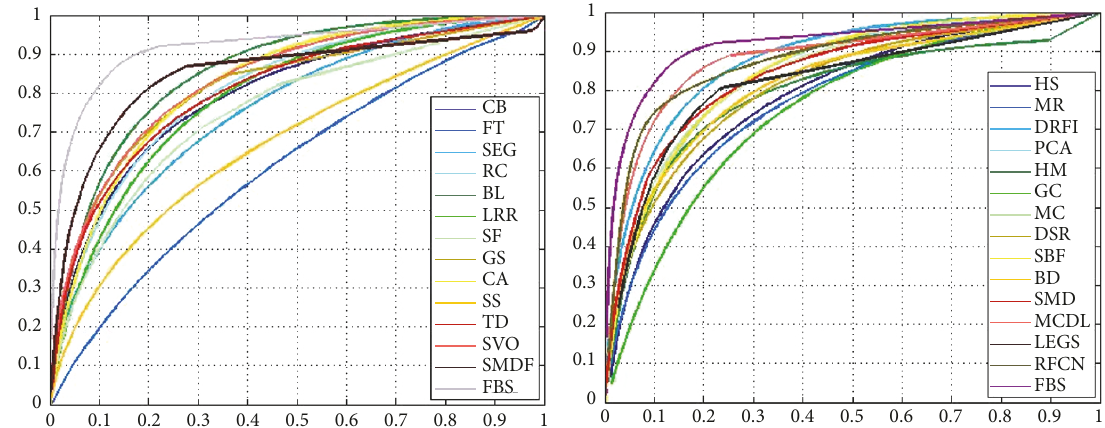
Figure 13: ROC curves of FBS and 27 state-of-the-art